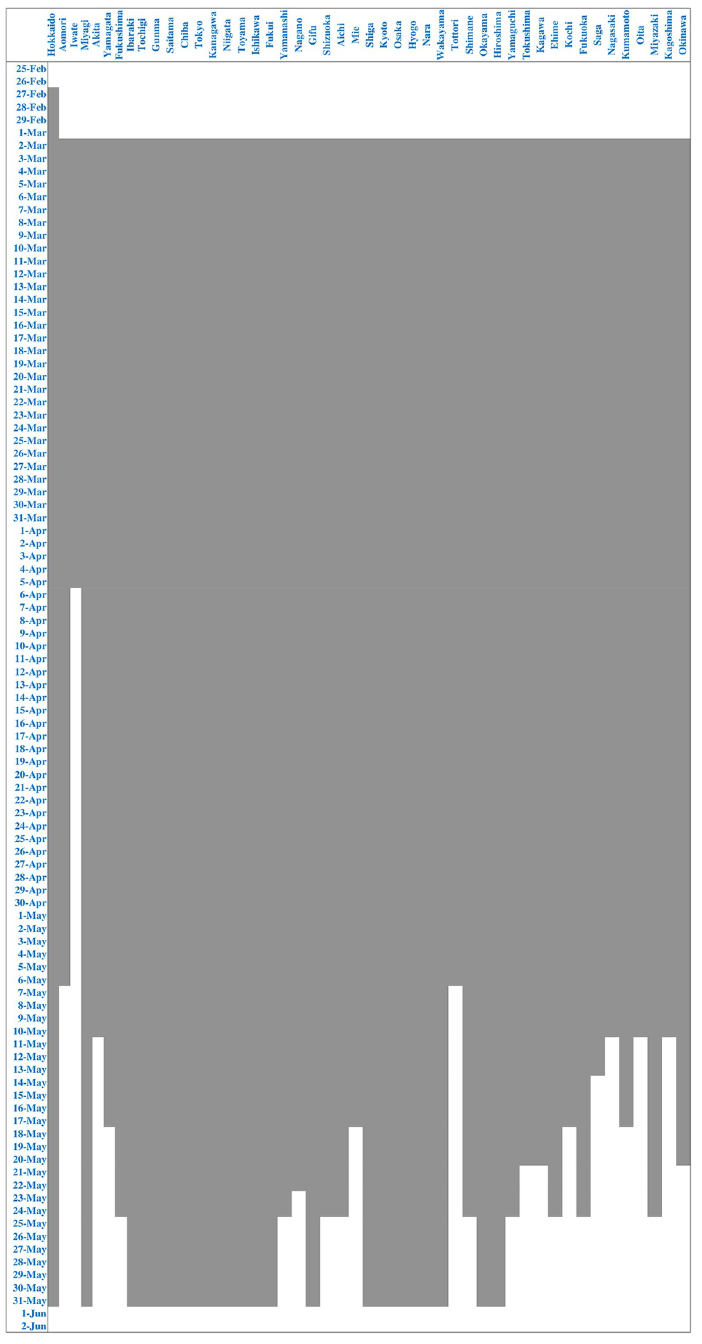
Fig 5. Start and end of school